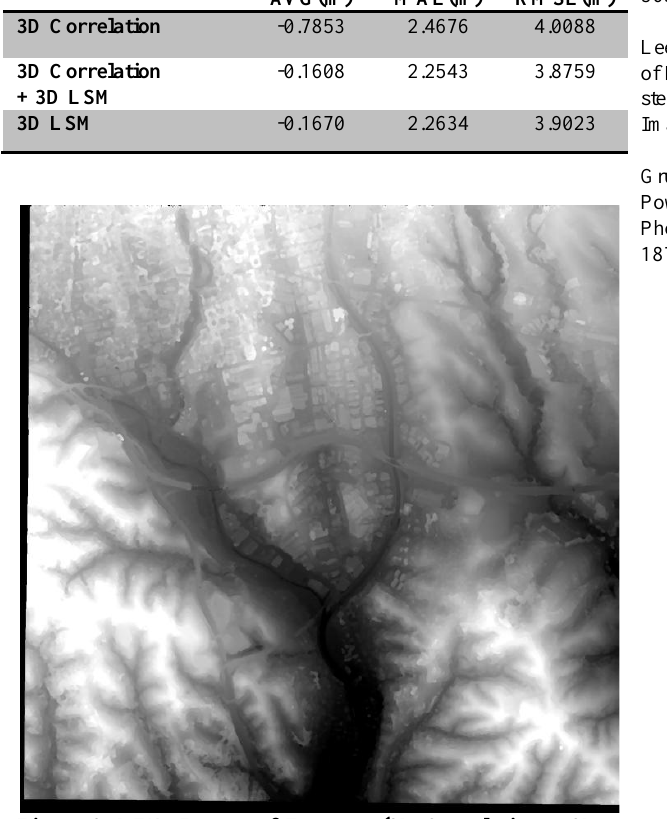
Figure 6. DEM Images of Terrassa (3D Correlation + 3D